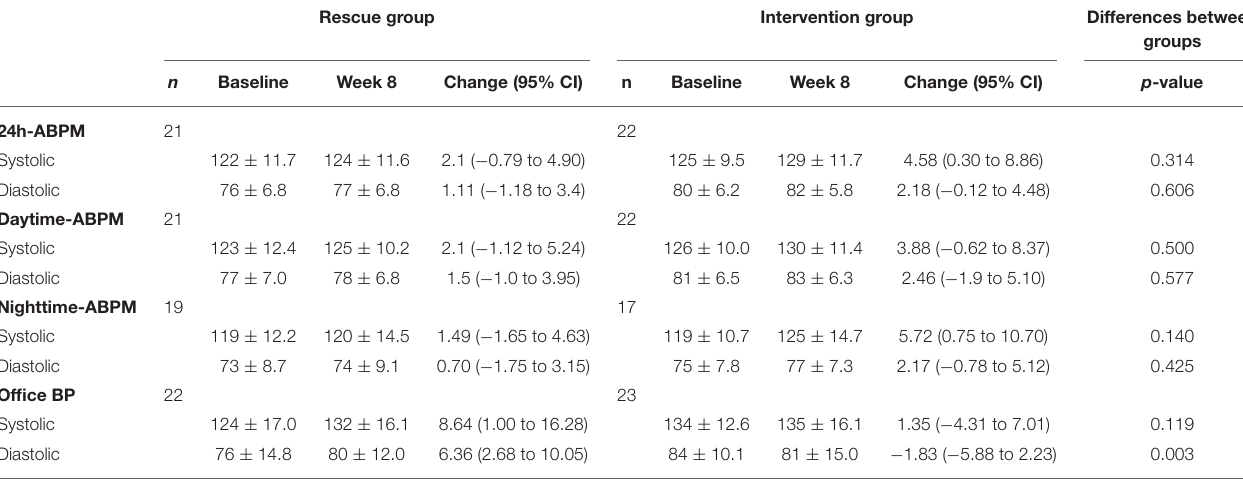
TABLE 2A | Mean office and 24h-ambulatory blood pressure measurements ( ± SD, mmHg) with respect to study group and point in time, and mean blood pressure change (95%CI,